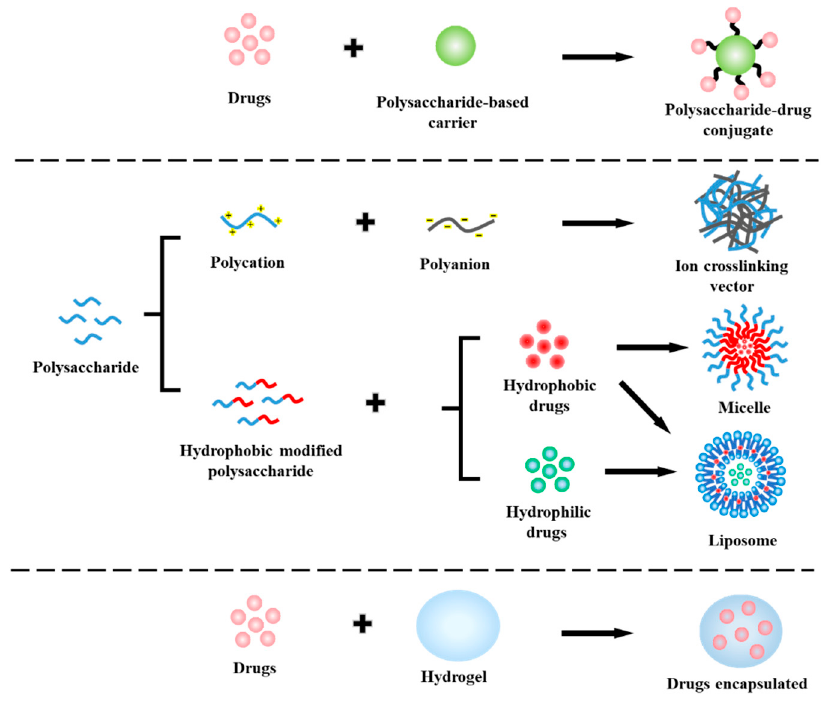
Figure 1. The design strategies of polysaccharide-based drug delivery systems (DDSs).